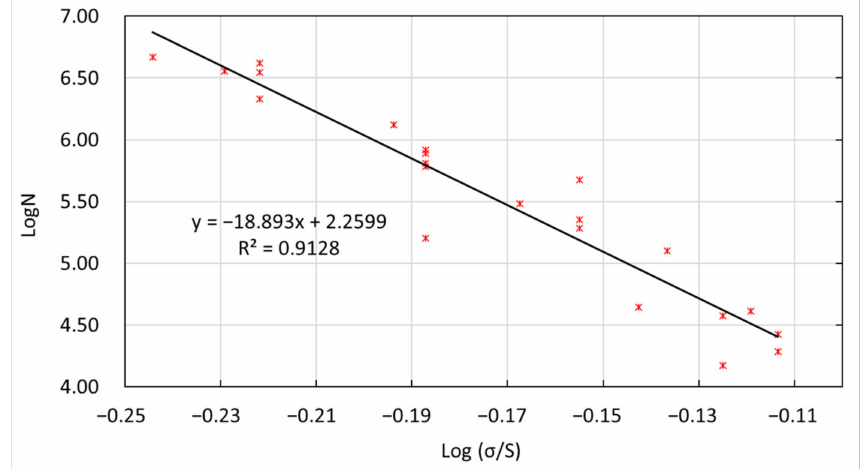
Figure 12. Fitting curves of LFSG fatigue test.